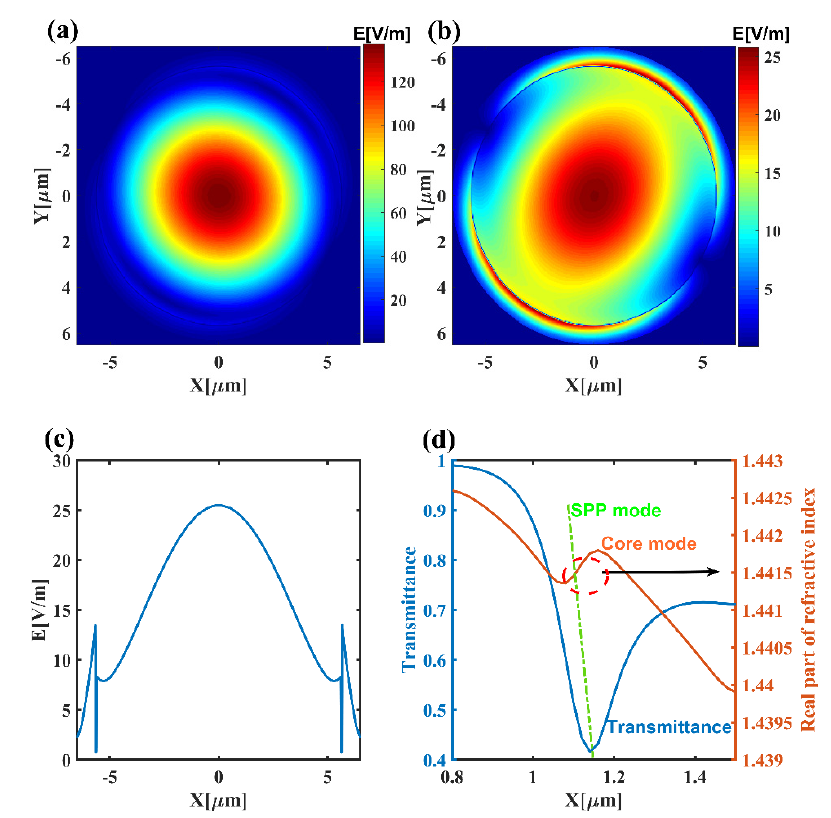
Figure 2. ( a ) Electric field diagram of the fundamental mode of fiber at 800 nm. ( b ) Electric field dia- gram of excited SPP. ( c ) Electric field enhancement diagram of fiber cross-section at SPR. ( d ) Real part of effective refractive index of fiber core mode and SPP mode, and transmission of fiber SPR